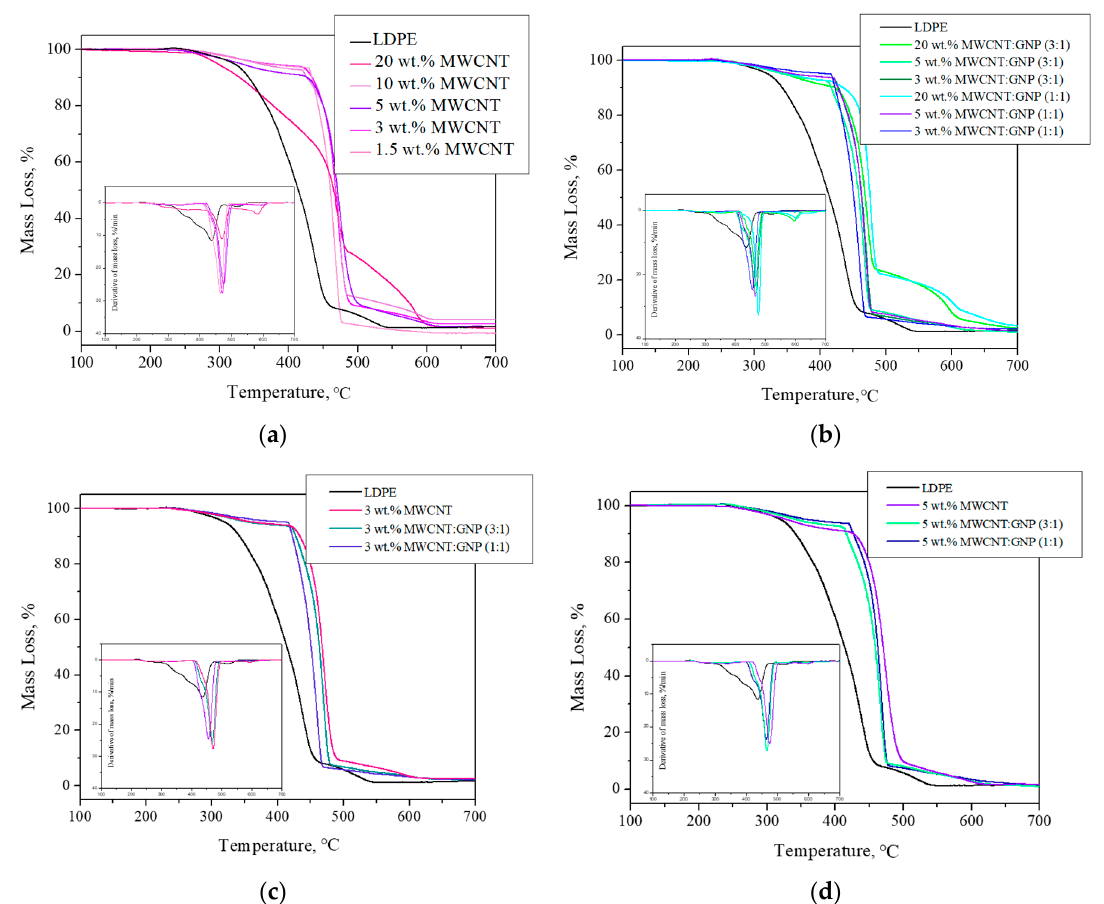
Figure 7. Mass loss and derivative of mass loss curves for: ( a ) LDPE/MWCNT nanocomposites; ( b ) LDPE/MWCNT + GNP hybrid nanocomposites; ( c ) LDPE-based nanocomposites at the total nanofiller content of 3 wt. %; and ( d ) LDPE-based nanocomposites at the total nanofiller content of 5 wt. %, measured in an oxidizing